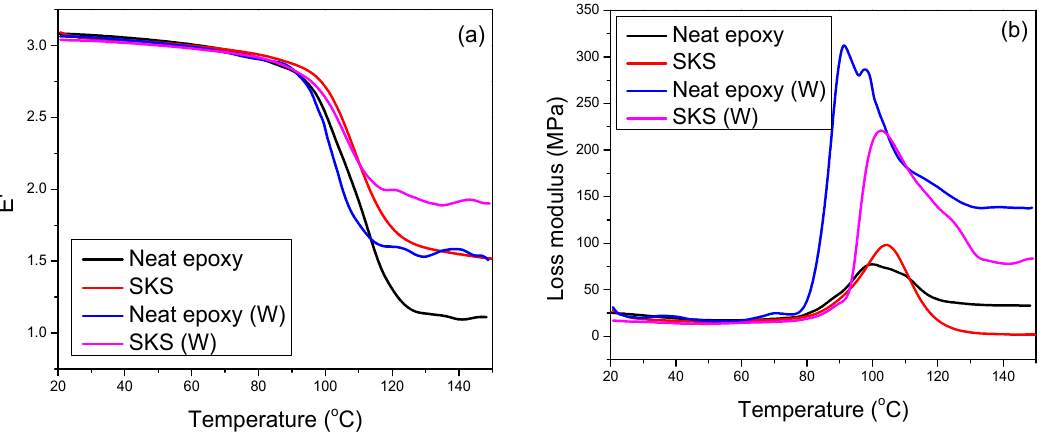
Figure 9. ( a ) Storage modulus and ( b ) loss modulus curves of neat epoxy and SKS composite before and after weathering.